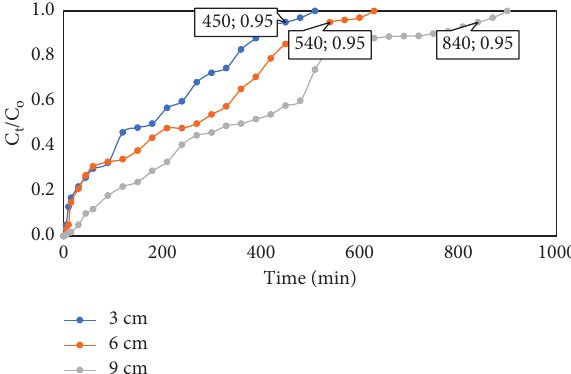
Figure 4: Cadmium removal exhausting time at different